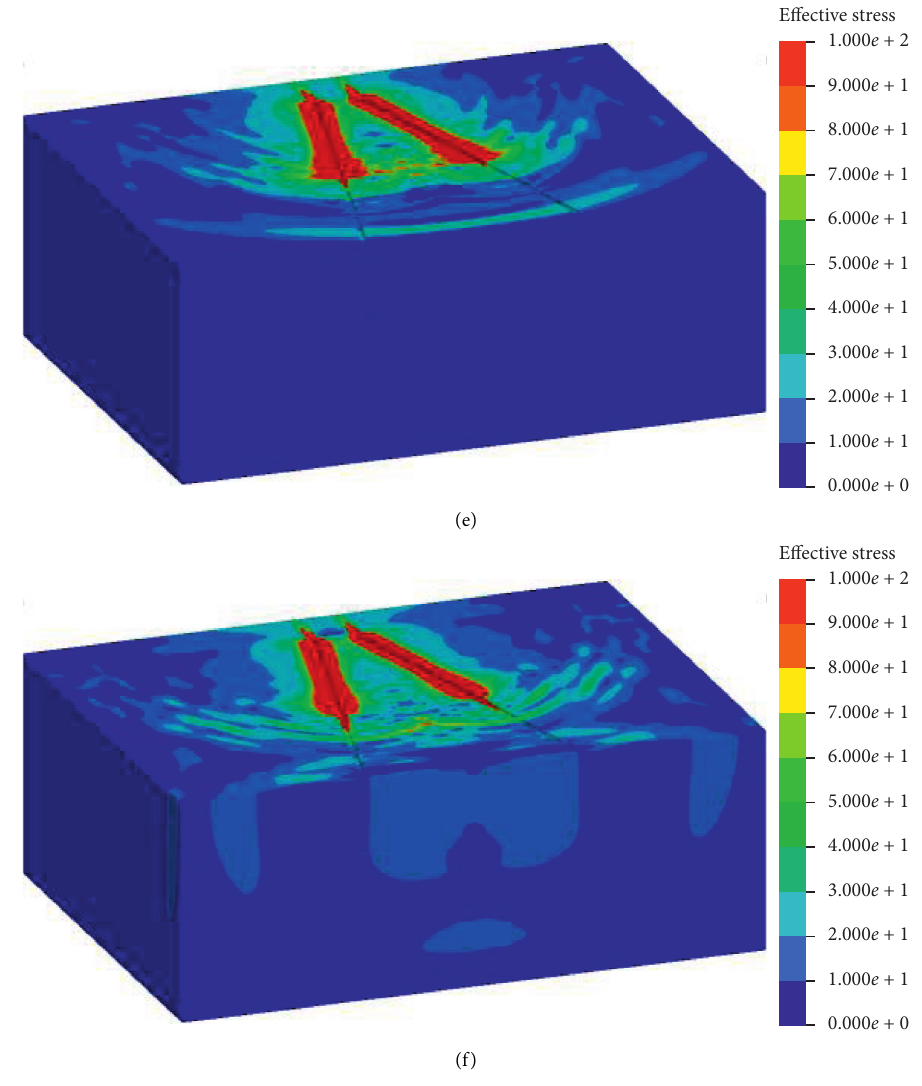
Figure 6: Effective stress wave evolution of cut blasting model for a large charge diameter. (a) t � 045 μ s. (b) t � 150 μ s. (c) t � 320 μ